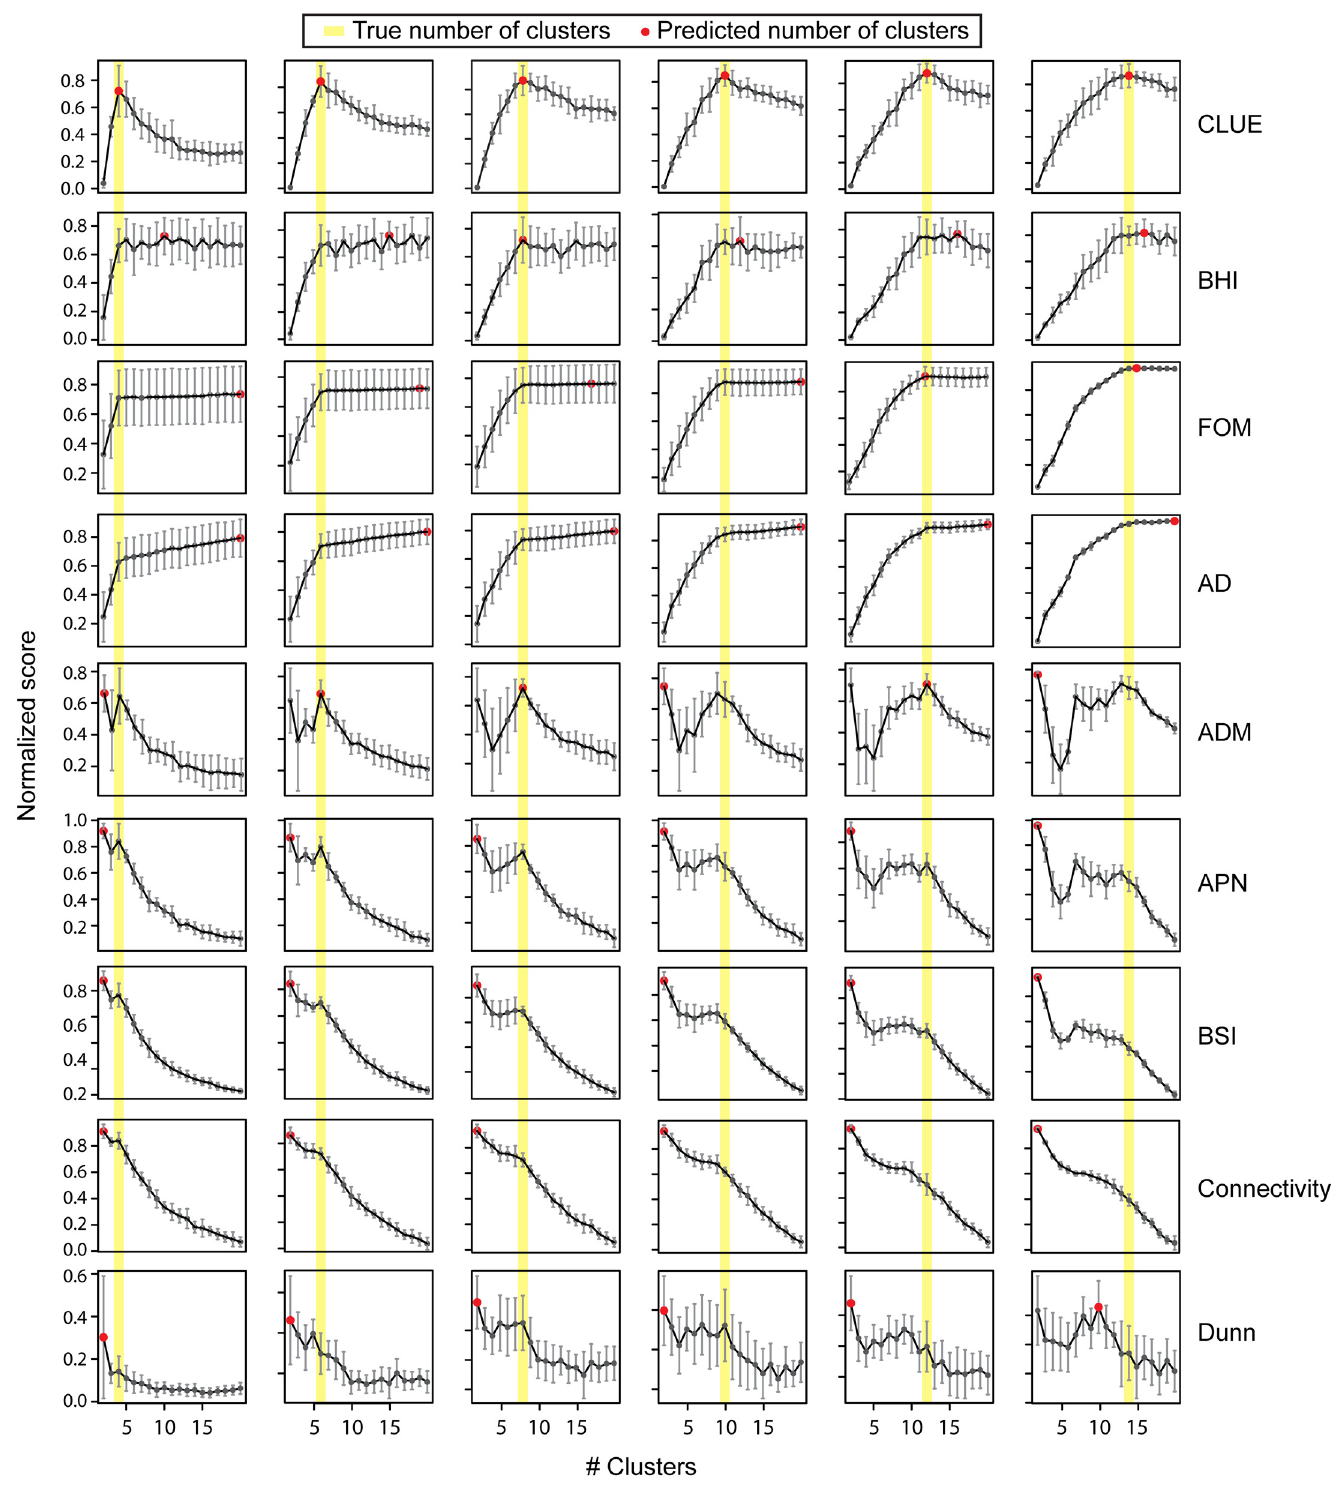
Fig 3. Comparison of CLUE with alternative approaches. Raw scores, representing the quality of clustering result for each k , for each method were normalized to be between 0 and 1 (y-axis). The higher the score, the more informative the resulting clustering is. The methods were evaluated based on how accurately they can recover the true number of clusters within a simulated dataset. The yellow line represents the true number of clusters in the simulated dataset, and the red dot denotes the predicted number of clusters in each case.